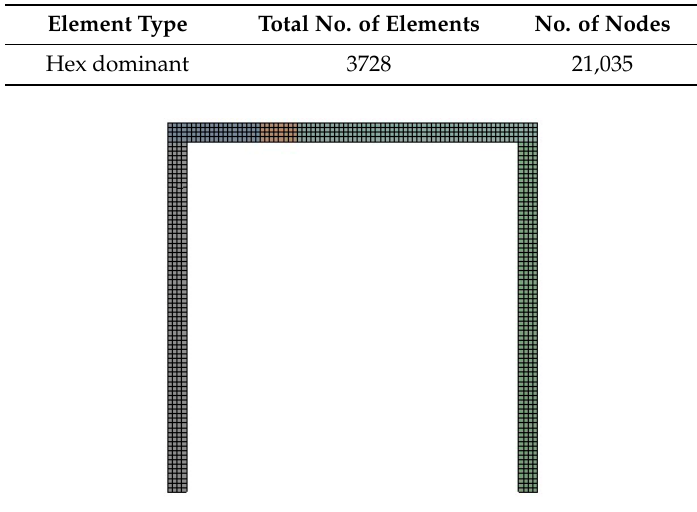
Figure 7. The mesh division result of gantry structure in ANSYS.